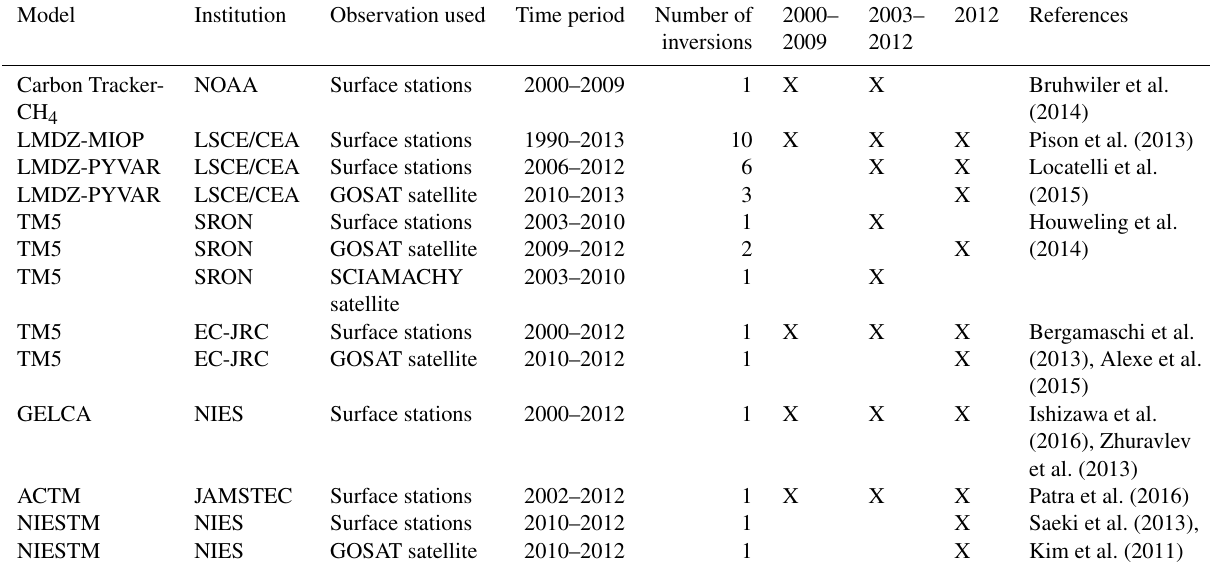
Table 3. Top-down studies used in this study with their contribution to the decadal and yearly estimates. For decadal means, top-down studies have to provide at least 6 years over the decade to contribute to the estimate. All top-down studies provided both total and per categories (including soil uptake)